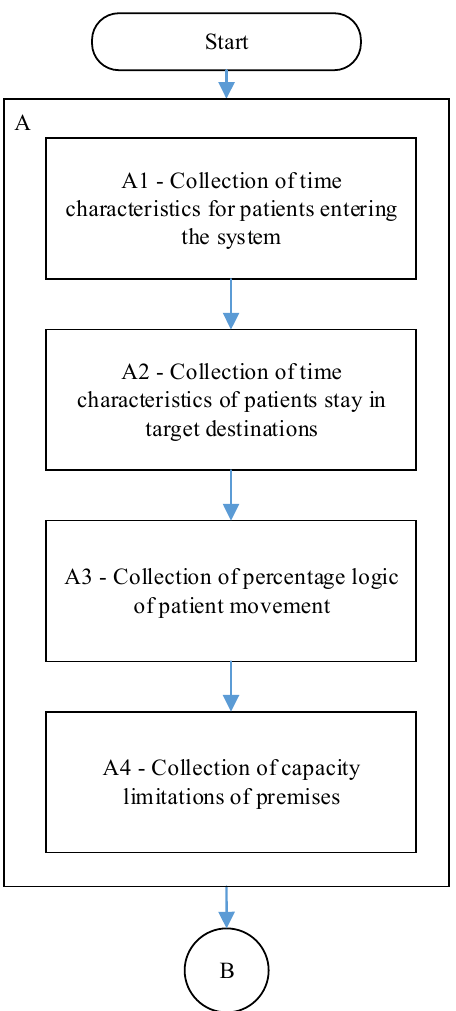
Figure 2. Block A phase of data collection needed to create a simulation model.